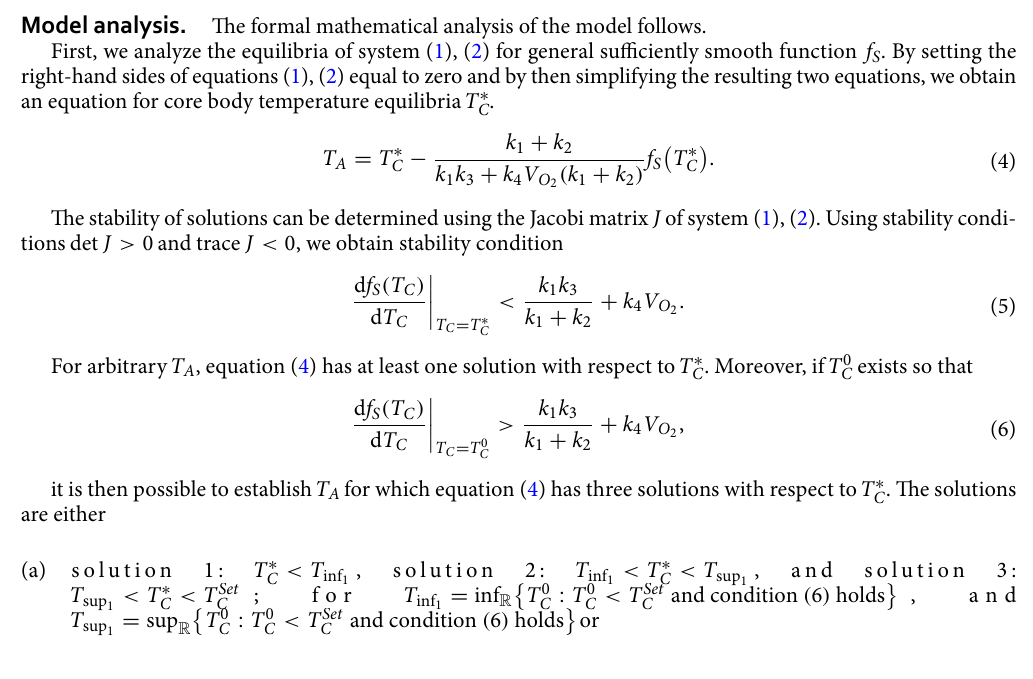
Figure 1. Different saturating functions with area below curve E S = 4 K p = 0.4 ( Example 1 ) and v = 0.5 , p = 2 ( Example 2